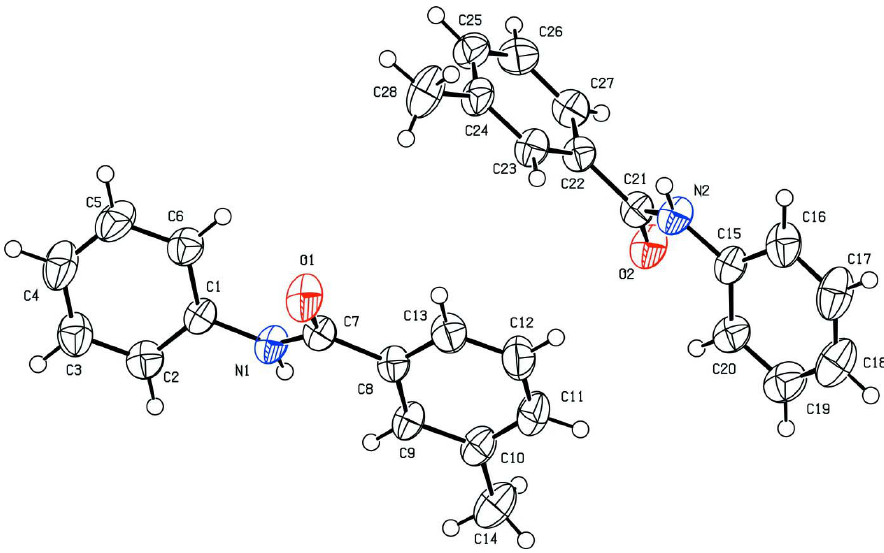
Figure 1 Molecular structure of the title compound, showing the atom labeling scheme. The displacement ellipsoids are drawn at the 50% probability level. H atoms are represented as small spheres of arbitrary